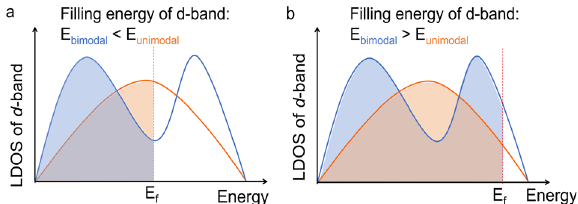
Fig. 4 Prediction performance of the statistical surrogate model for RMSAD. a Trained on binary/ternary data and validated on quaternary data. b Trained on binary/ternary/quaternary data and tested on quinary